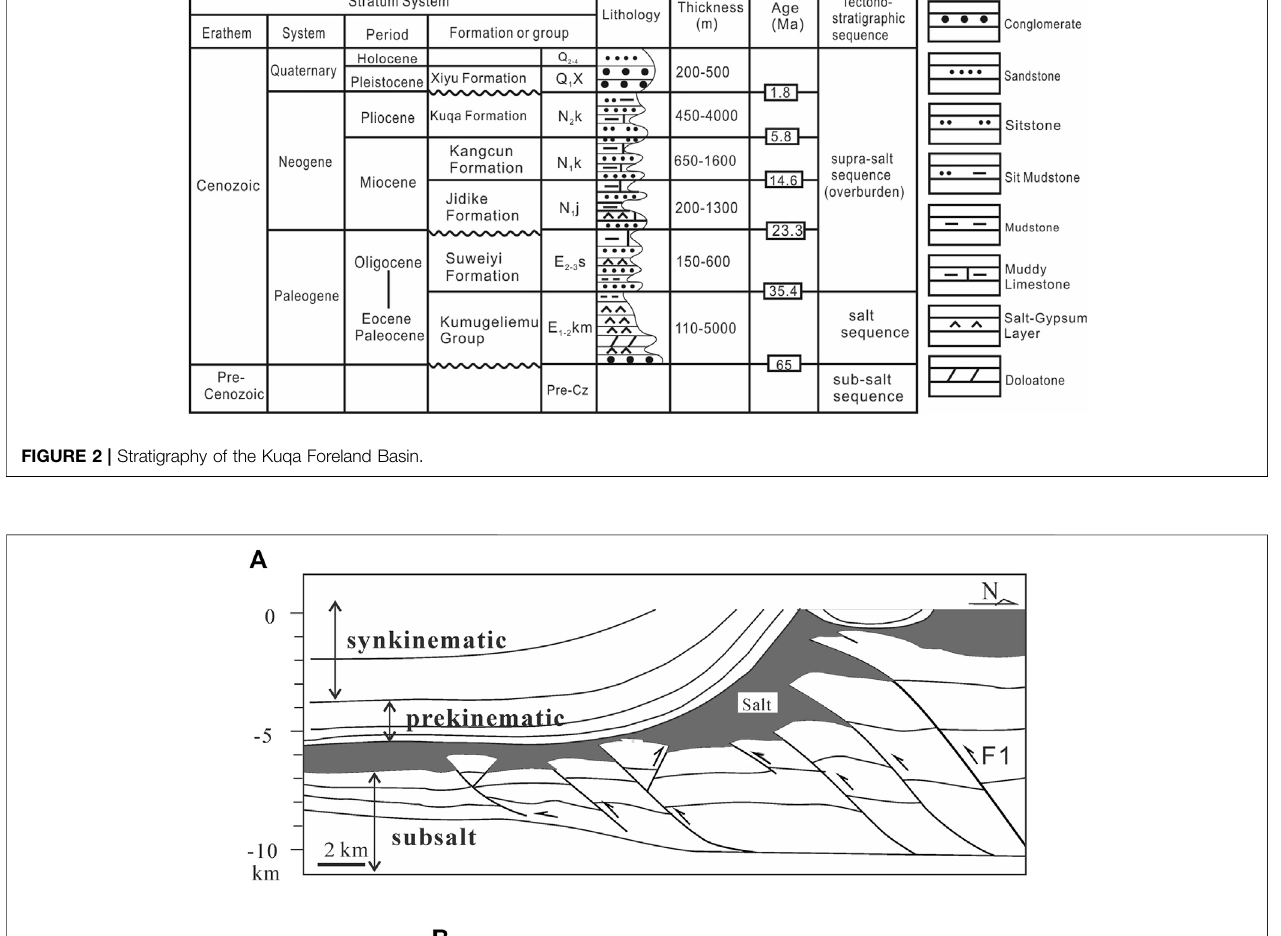
Frontiers in Earth Science |